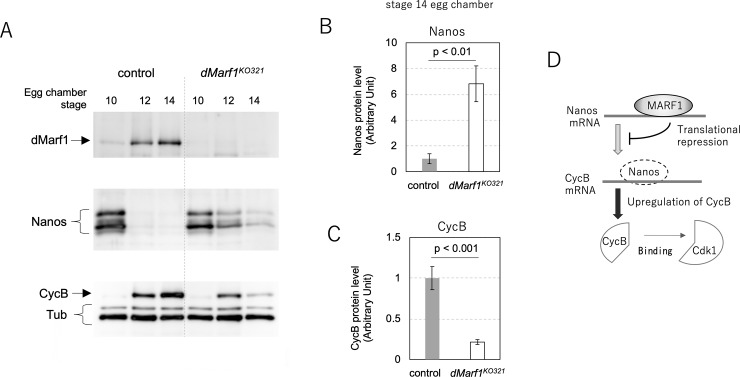
dMarf1 translationally represses Nos in the late stages of oogenesis.(A) Western blot showing protein expression at each stage of oogenesis. Upper panel, dMarf1; middle panel, Nos; bottom panel, Cyclin B, and the loading control, α-tubulin. (B) Quantitative analysis of Nos protein expression in stage 14 egg chambers. The mean and standard deviation of Nos expression are shown in terms of arbitrary unit (p < 0.01; Student’s t-test). (C) Quantitative analysis of CycB protein expression in stage 14 egg chambers. The mean and standard deviation of CycB expression are shown in terms of arbitrary unit (p < 0.001; Student’s t-test). (D) Schematic model of dMarf1 function. In wild type females, dMarf1 coordinates the late stages of oogenesis. dMarf1 binds to nos mRNA and inhibits its protein translation. Consequently, CycB expression is upregulated at the onset of oocyte maturation, which results in the formation of the MPF complex to promote meiosis. In the absence of dMarf1, Nos is expressed until stage14 and CycB is downregulated, which in turn reduces MPF activity.